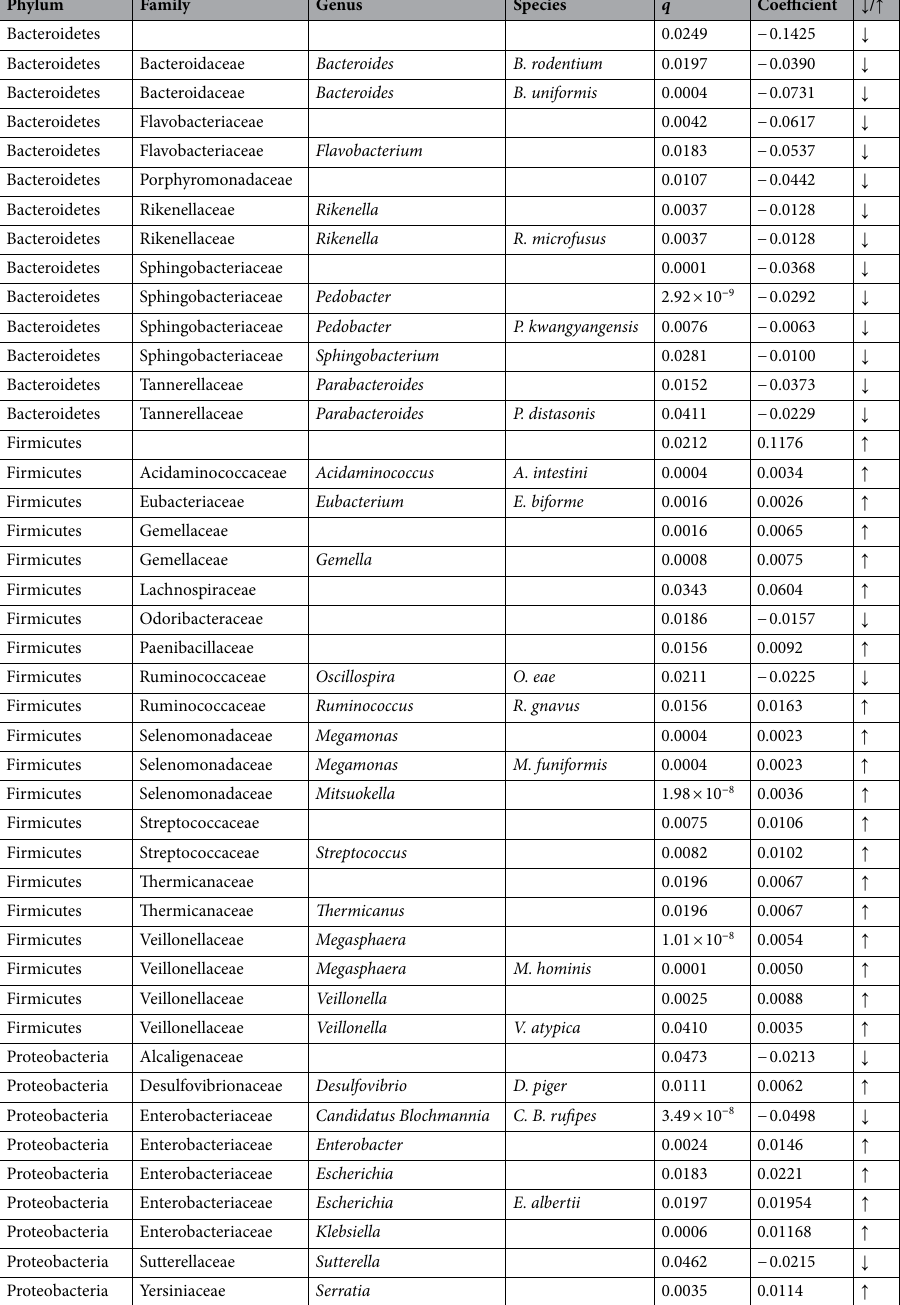
Table 2. Statistically significant differences in the relative abundance of bacterial taxa between OB and NW. A multivariate association with linear models (MaAsLin) was used to perform a multivariate analysis on GM composition between OB and NW (adjusted for sex, age and smoking status) on the Galaxy Computational Tool v.3.5.2. NW = normal-weight healthy controls, OB = overweight and obese patients, q : p values adjusted for Benjamini and Hochberg false discovery rate (FDR) correction test for multiple comparisons (FDR < 0.05), Coefficient = median difference between OB and NW (median relative abundance in OB minus median relative abundance in NW), ↓ = significantly reduced in OB, ↑ = significantly increased in OB. q equal to or less than 0.05 was considered statistically